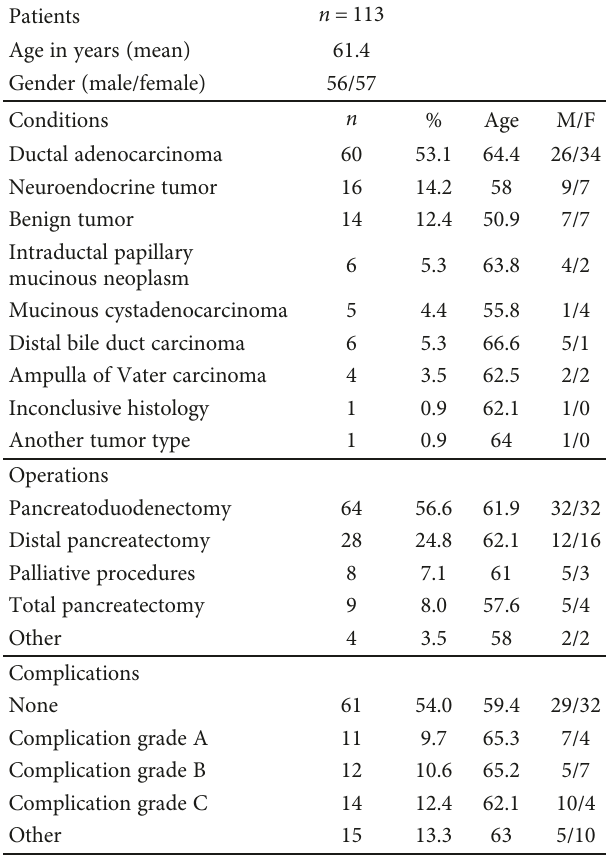
Table 1: Demographic and clinical data of the study